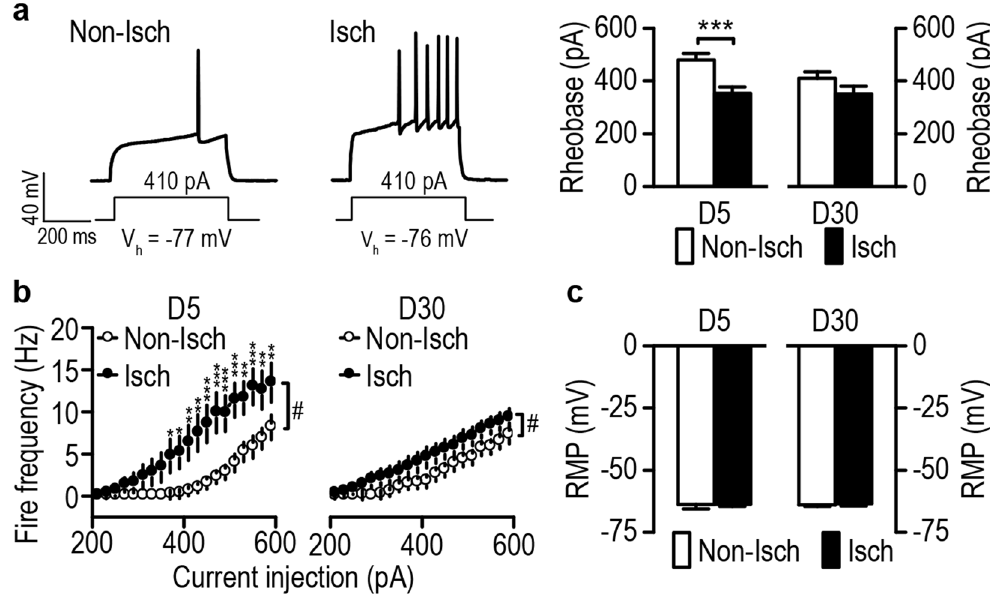
Figure 3. Stroke increases the excitability of DMS neurons in alcohol-drinking rats. Sprague-Dawley rats were trained to consume 20% alcohol for 8 weeks using the intermittent-access 2-bottle choice drinking procedure. Stroke was induced as described in the Experimental Procedures section and the rats were sacrificed on D5 or D30 post-stroke for slice electrophysiological measurement. Evoked action potentials were measured using current-clamp recording in DMS neurons from coronal slices prepared from the non-ischemic (Non-Isch) and ischemic (Isch) hemispheres. ( a ) Stroke reduced the rheobase current in DMS neurons on D5, but not D30. Left and middle, representative DMS action potential traces in response to the same magnitude of injected current on the Non-Isch and Isch sides on D5. Right, bar graphs showing a lower rheobase current on the Non-Isch side than on the Isch side on D5, but not D30. *** p < 0.0001 by t test. n = 12 neurons from 3 rats (Non-Isch) and 12 neurons from 4 rats (Isch) for both D5 and D30 groups. ( b ) Stroke increased the evoked firing frequency in DMS neurons on D5 (left) and D30 (right). # p < 0.05 by two-way RM ANOVA; * p < 0.05, ** p < 0.01, and *** p < 0.001 by post-hoc SNK test. D5: n = 12 neurons from 3 rats per group; D30: n = 12 neurons from 3 rats (Non-Isch) and 12 neurons from 4 rats (Isch). ( c ) Bar graphs showing no difference in the resting membrane potentials (RMP) on the Non-Isch and Isch sides on D5 or D30. n = 12 neurons from 3 rats (Non-Isch) and 12 neurons from 4 rats (Isch) for both D5 and D30